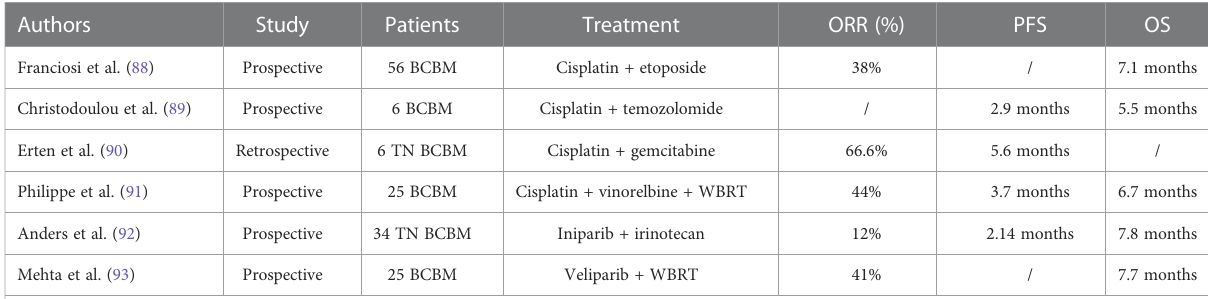
TABLE 2 Ef fi cacy of combined chemotherapy trials in